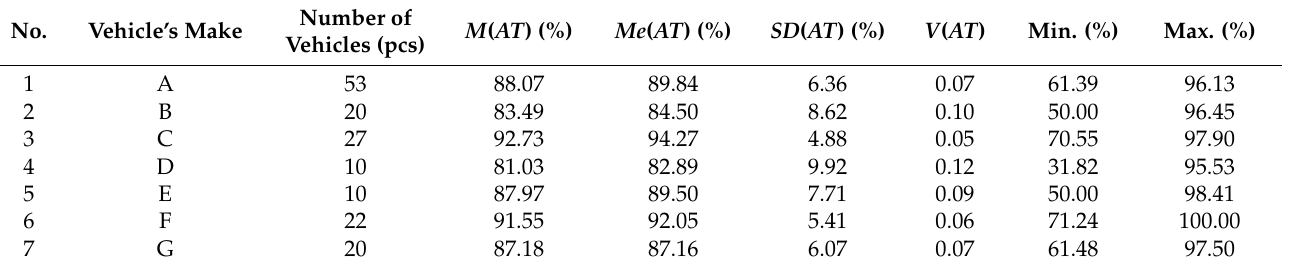
Table 2. Descriptive statistics for the buses’ AT availability indicators.